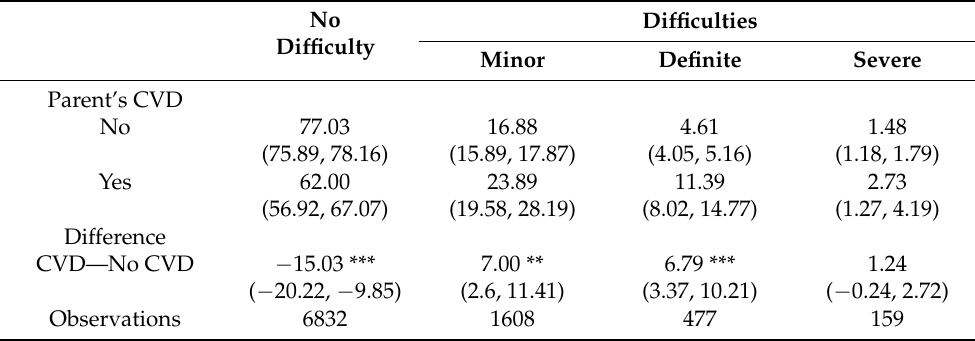
Table 2. Share of children having difficulties in emotions, concentration, behavior, or being able to get along with other people—by parent’s cardiovascular diseases.